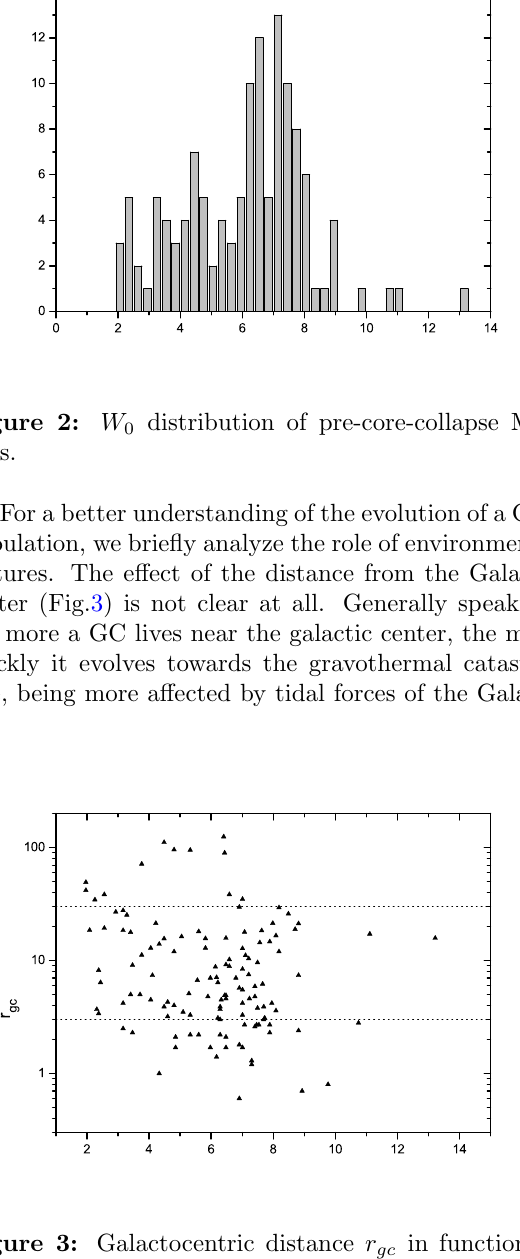
Figure 3: Galactocentric distance r gc in function of W 0 . The dashed lines represent the values at 3Kpc and 30Kpc.